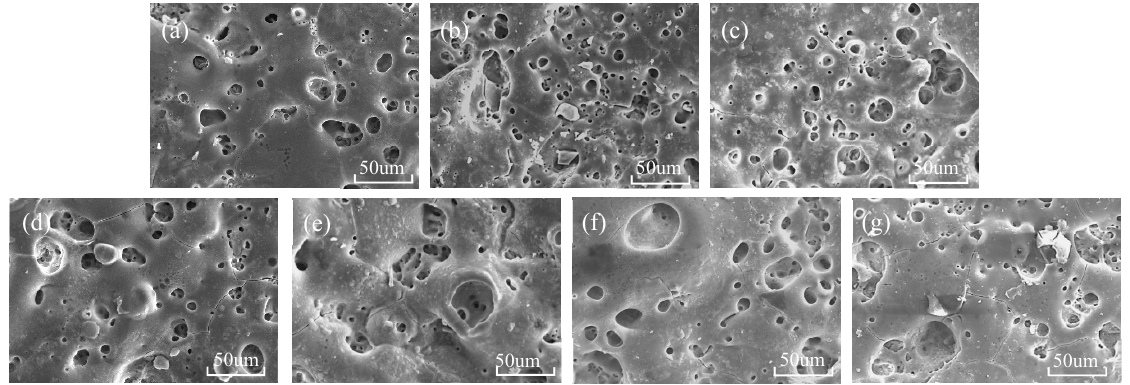
Figure 3. Surface morphology of MAO coatings: ( a ) S0; ( b ) S1; ( c ) S2; ( d ) S3; ( e ) S4; ( f ) S5; and ( g ) S6.